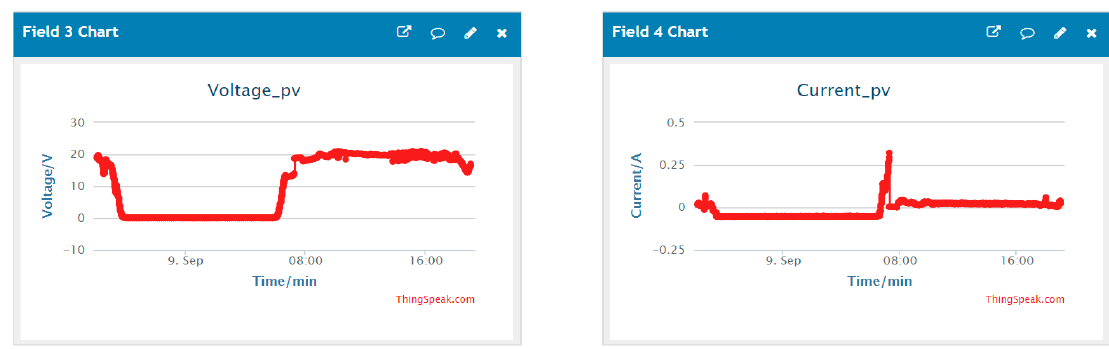
Figure 17. Voltage and current of battery in one day.